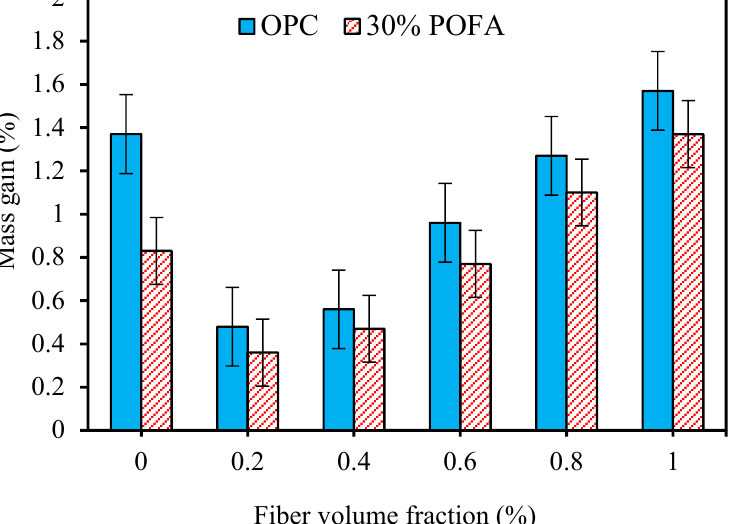
Figure 6. The effects of the WPFT fibers on the mass gain of concrete samples exposed to a MgSO 4 solution.